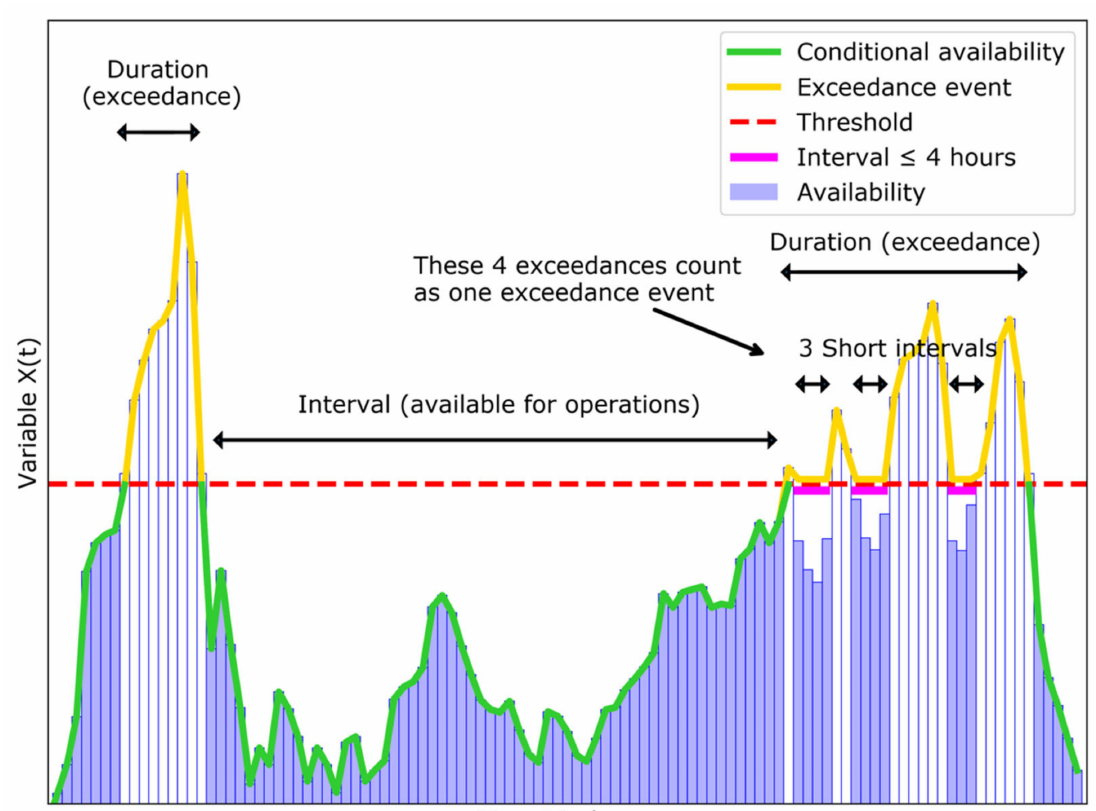
Figure 1. Illustration of the definitions to estimate and analyze the port operability risk via the conditional availability, exceedance interval, frequency and